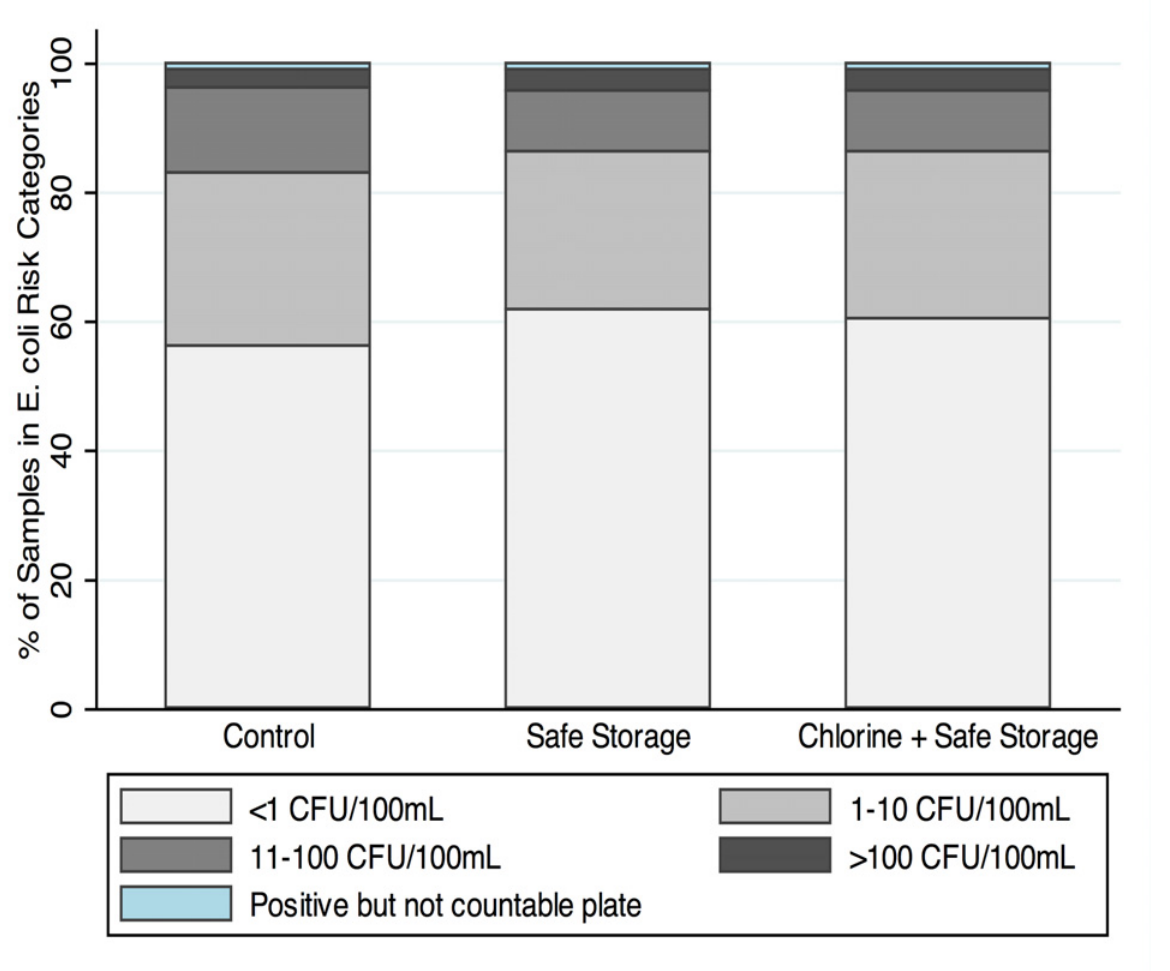
Fig 2. Categories of E . coli counts in tubewell water across arms (see S6